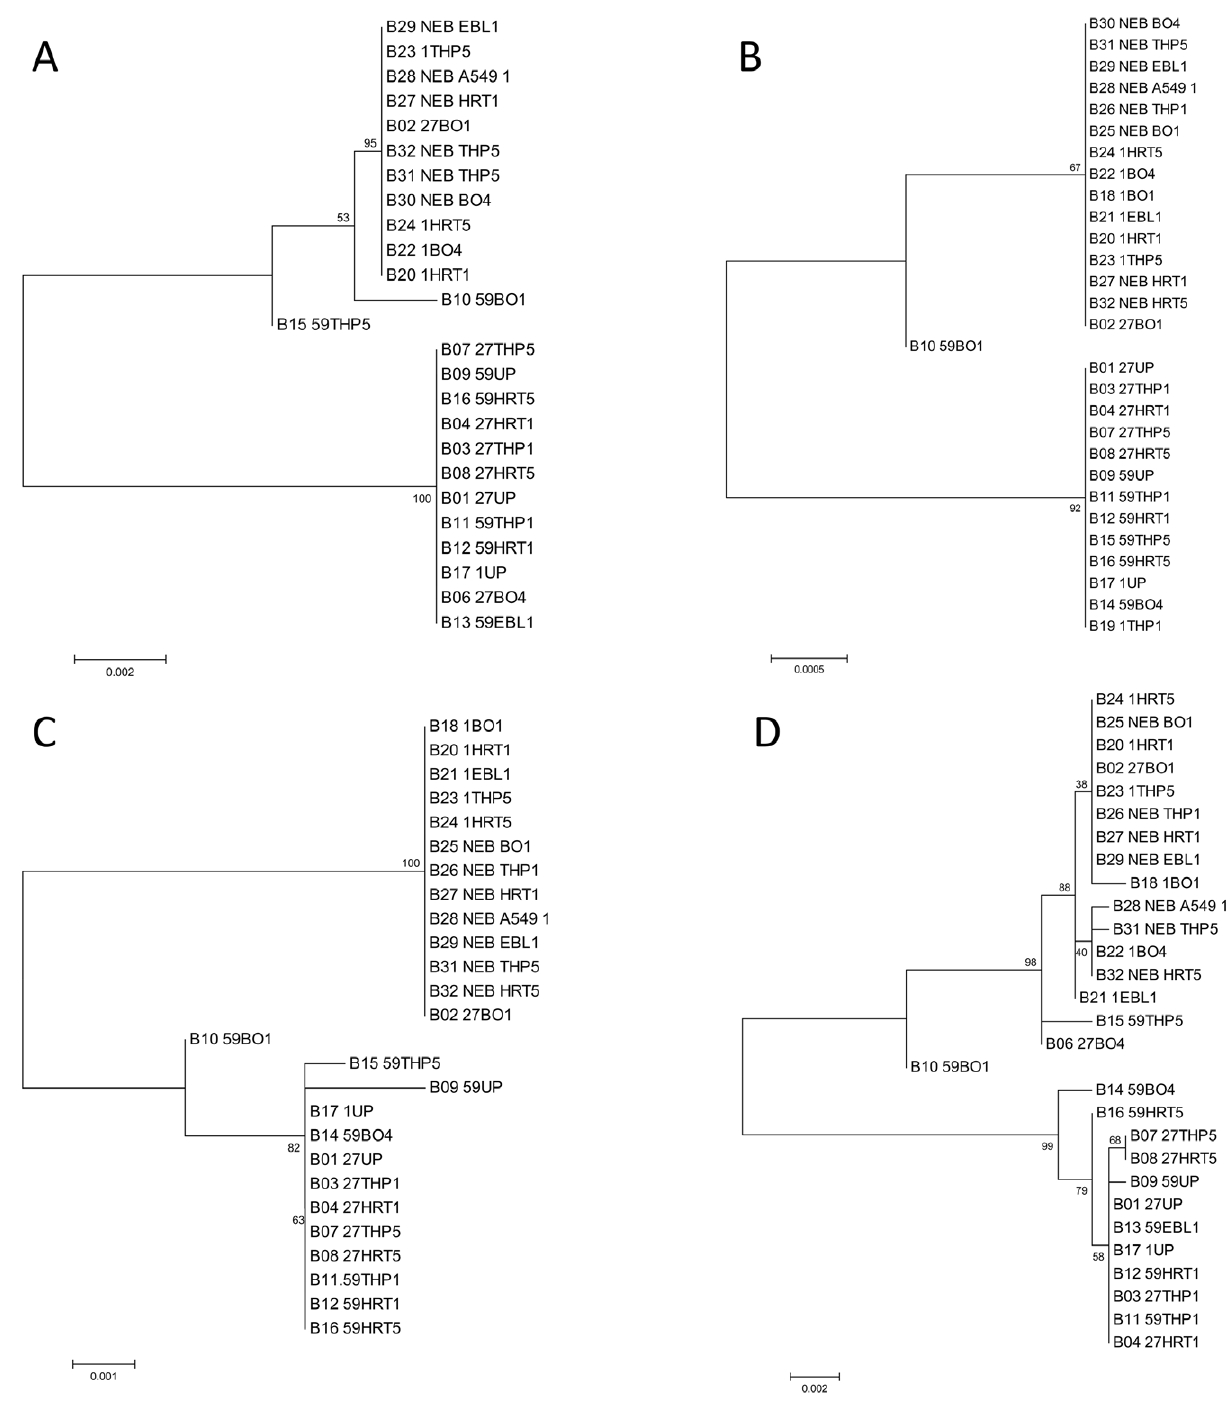
Figure 1. Phylograms generated using consensus sequence for the coding regions of Nsp1, Nsp3, Nsp14, and Spike. (A–D, respectively.) Samples are labeled using sample sequence identifier (B ## ), samples # , cell type, and passage number. Phylogeny was inferred by using the Maximum Likelihood method based on the Tamura-Nei model [42]. The tree with the highest log likelihood is shown. The percentage of trees in which the associated taxa clustered together is shown next to the branches. The tree is drawn to scale, with branch lengths measured in the number of substitutions per site. Codon positions included were 1st + 2nd + 3rd + Noncoding. All positions containing gaps and missing data were eliminated. There were a total of 1671 (nsp1), 851 (nsp3), 1561 (nsp14), and 1457 (spike) positions in the final dataset. The genomic regions included in the analysis span nts 2764–8460 (nsp1), 10858–11714 (nsp3), 17910–19472 (nsp14), and 23641–27732 (spike), as numbered according to accession AB354579. Analyses were conducted using MEGA5 [43]. Samples may be absent from analysis due to inadequate sequence data generated for a particular coding region, however in cases where fewer positions gave the same phylogram as that generated using more positions, fewer positions were used to allow inclusion of more samples in the phylogram.